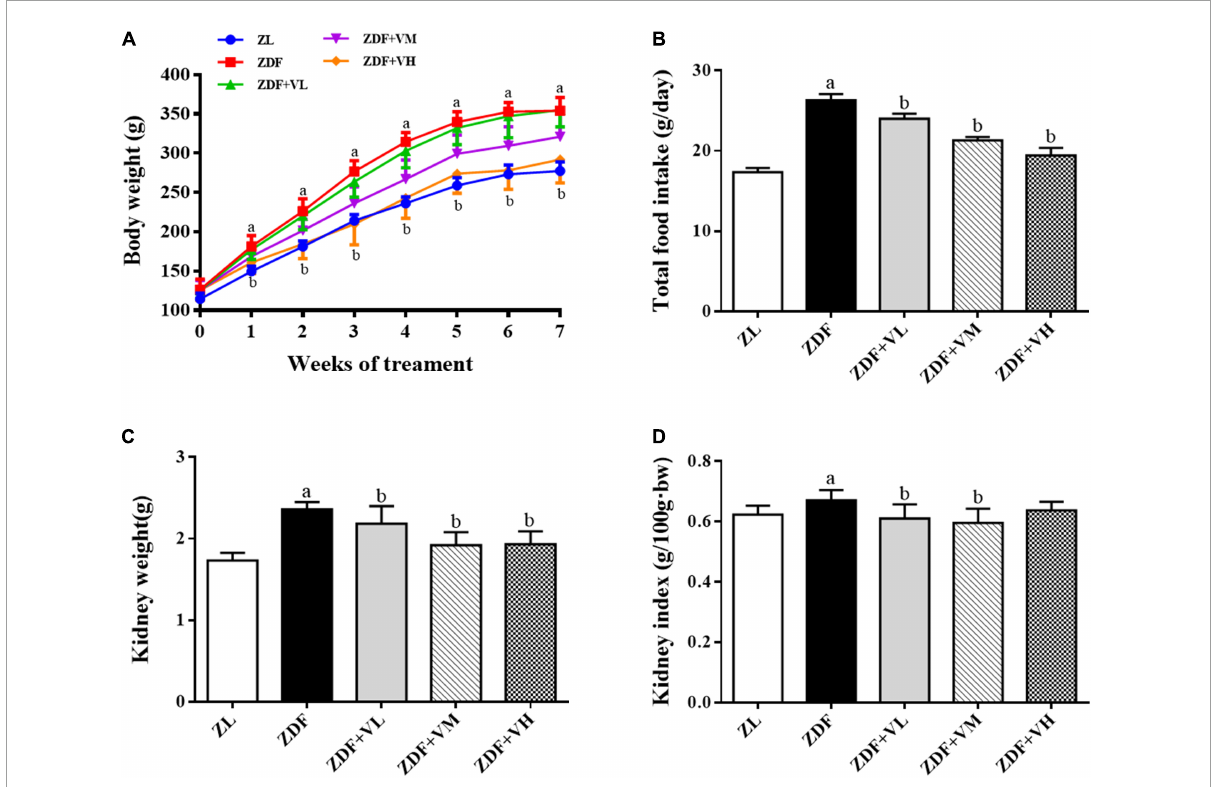
FIGURE1 Effects of 1,25(OH) 2 D 3 on the body weight, food intake, and kidney index in Zucker rats. (A) Variation trends of body weight as weeks of 1,25(OH) 2 D 3 treatment. (B) Total food intake. (C) Kidney weight. (D) Kidney index. ZL, Zucker lean group; ZDF, Zucker diabetic fatty group; ZDF + VL, ZDF + low-dose 1,25(OH) 2 D 3 group (2 µ g/kg · bw); ZDF + VM, ZDF + middle-dose 1,25(OH) 2 D 3 group (8 µ g/kg · bw); ZDF + VH,